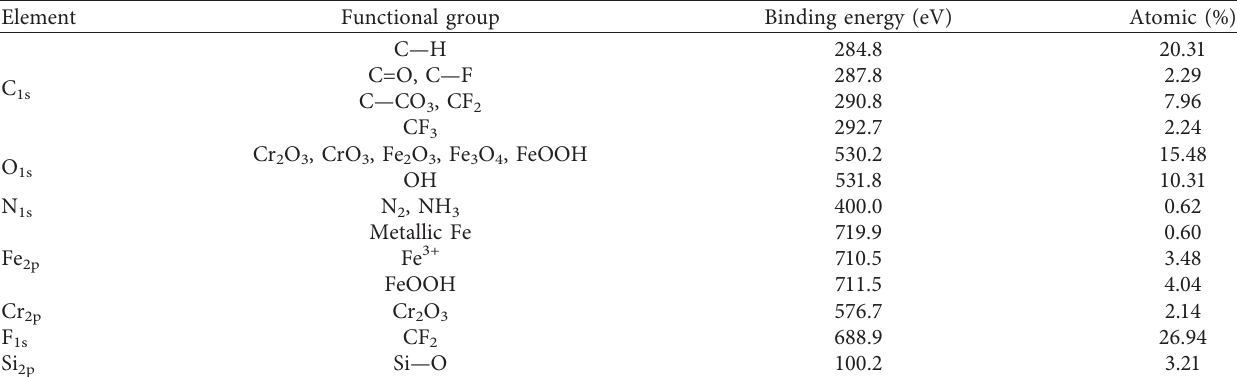
Table 4: Surface elemental compositions and functional groups of S1 after fluorination (FS1).